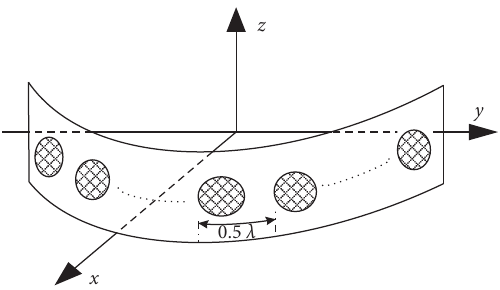
Figure 3: Schematic view of the conformal array with 30